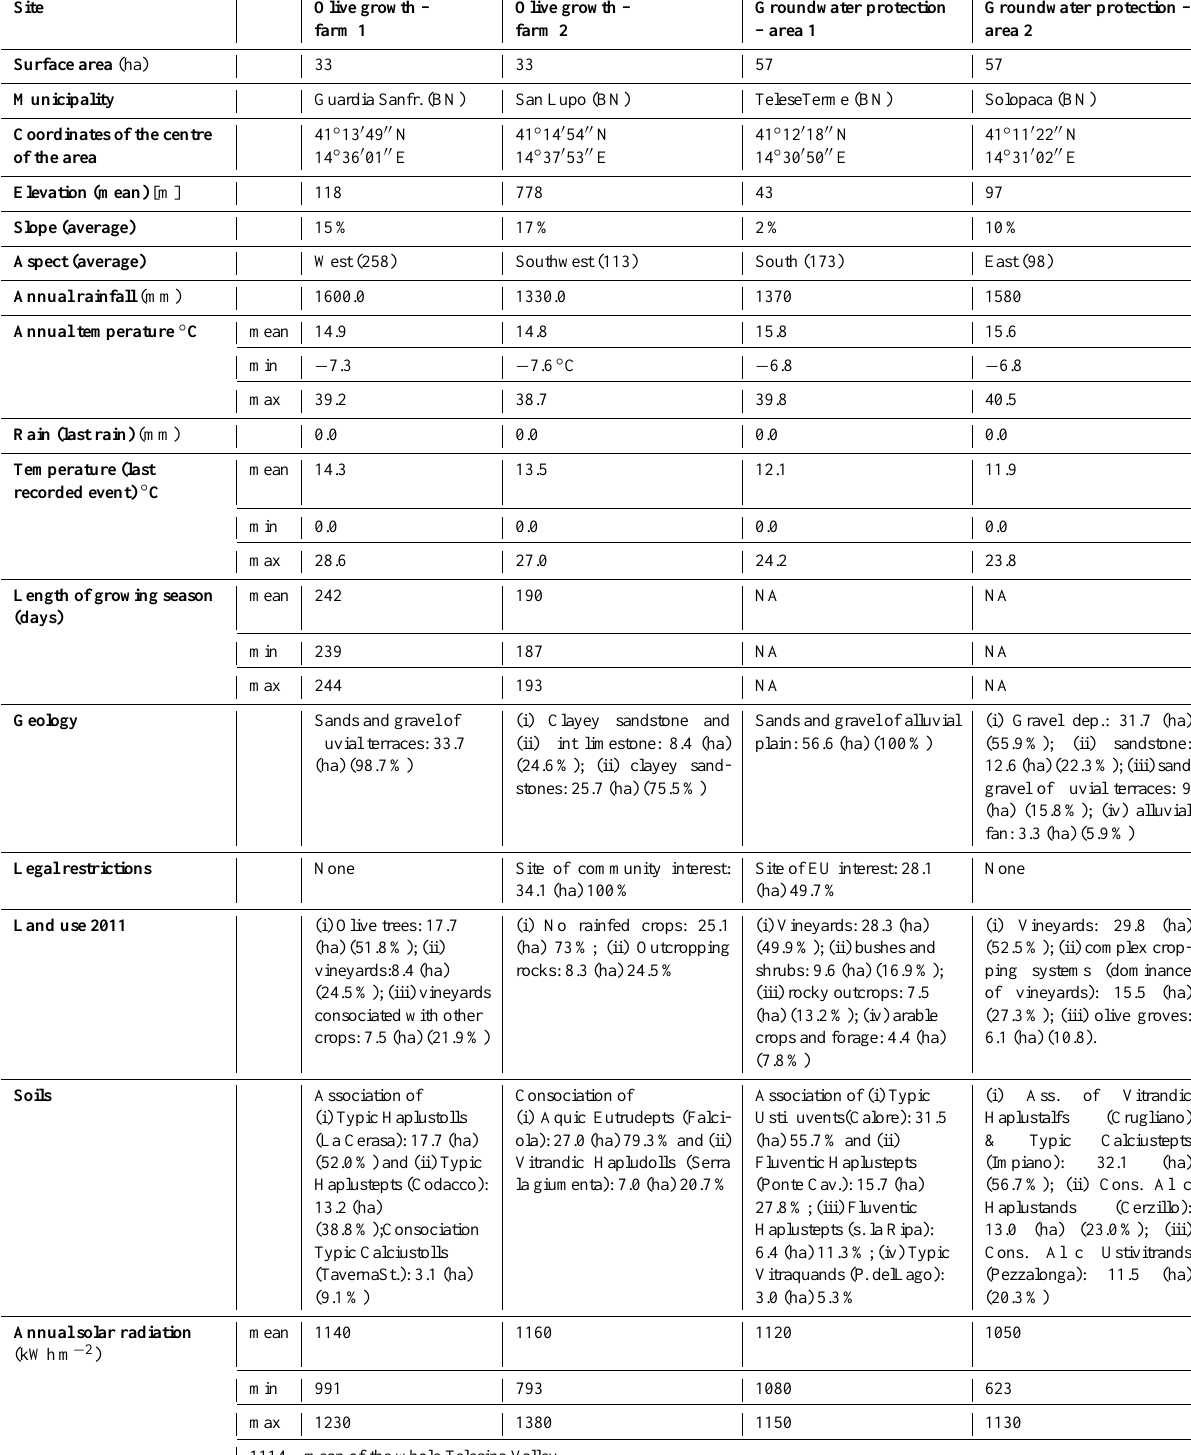
Table 4. Detailed spatial information about Figs. 6 (olive growing) and 8 (groundwater protection). Var. stands for